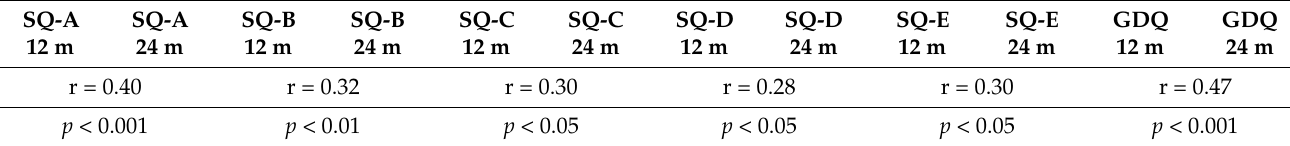
Table 3. Pearson correlation test between neurodevelopmental scores at 12 and 24 months.